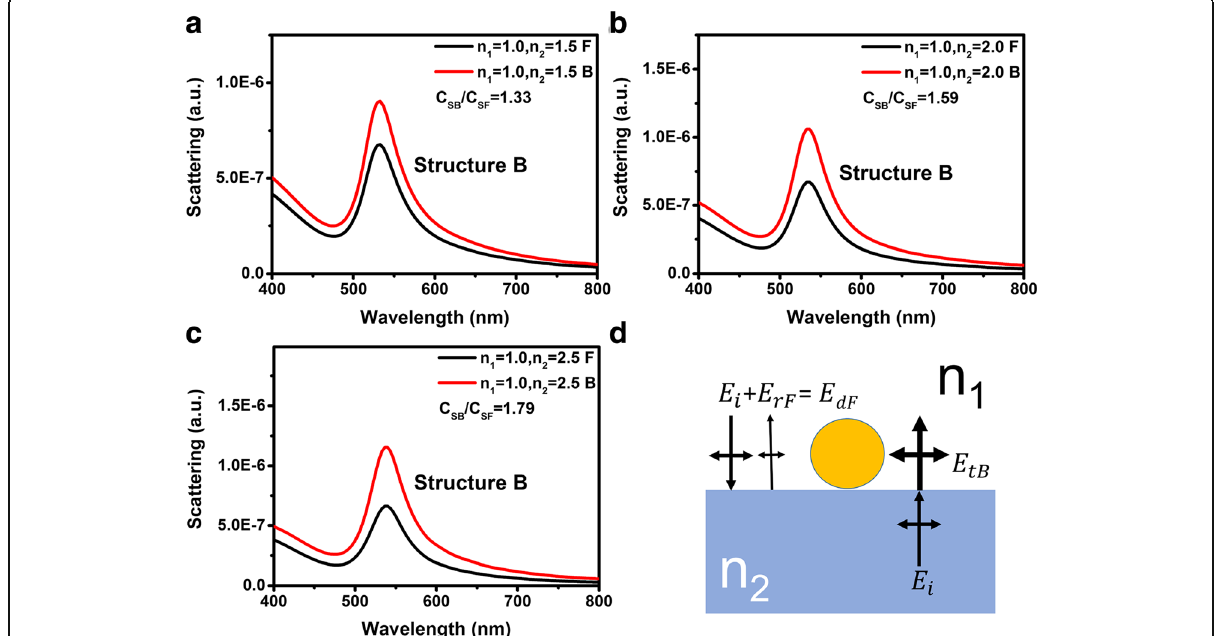
Fig. 6 a – c Scattering spectra for varying n 2 = 1.5, 2.0, and 2.5 of structure B respectively. Black and red lines represent the front and back incident cases respectively. d Schematic diagram of local driving electric field of structure B for different incident directions